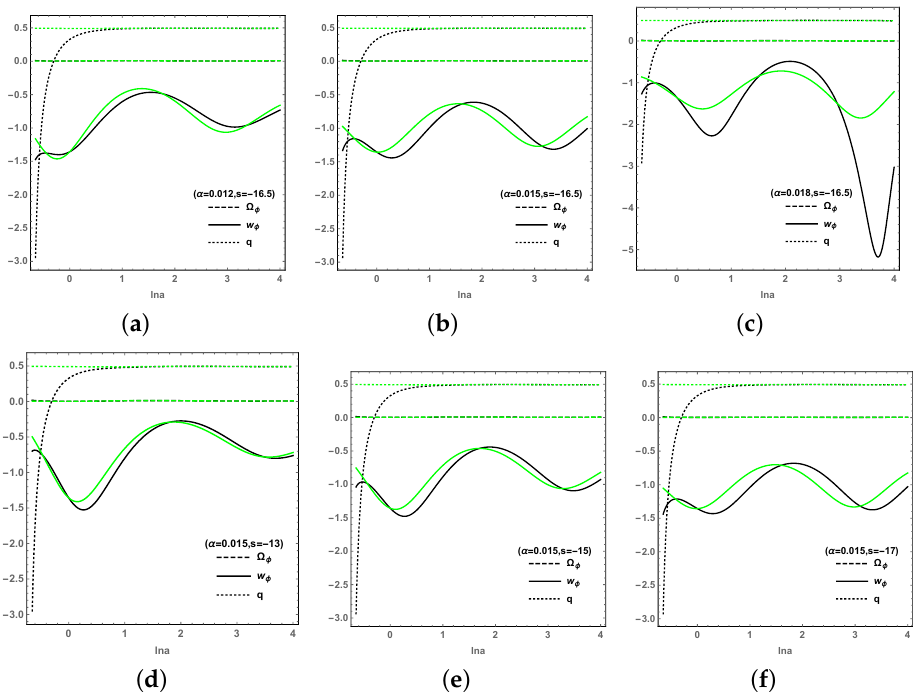
Figure 5. The comparison of the evolutions of Ω φ , w φ and q in EC (green) with those in LQC (black) around P 2 by the initial condition x 0 = 0.6, y 0 = 0.15, z 0 = 0.1. ( a – c ) correspond to different coupling parameters α = 0.012,0.015,0.018 and fixed potential parameter s = − 16.5; alternately, ( d – f ) correspond to different potential parameters s = − 13, − 15, − 17 and fixed coupling parameter α =